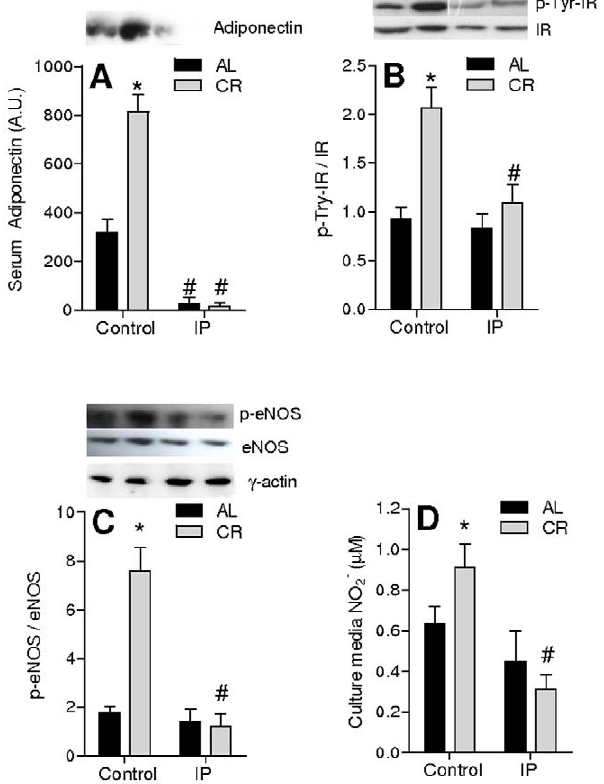
Figure 4. Adiponectin in CR serum promotes insulin receptor and eNOS phosphorylation, resulting in NO N release. ( A ) Adiponectin levels in AL and CR sera before and after immunoprecip- itation (IP). ( B ) Tyr phosphorylation in insulin receptors immunoprecip- itated from homogenates of VSMC cultured for 24 h in the presence of CR or AL serum, with (IP) or without (Control) prior adiponectin immunoprecipitation. ( C ) eNOS Ser1177 phosphorylation in homogenates from VSMC cultured for 24 h in the presence of CR or AL serum, with (IP) or without (Control) prior adiponectin immunoprecipitation. ( D ) NO 2 2 levels in the media from VSMC cultured for 24 h in the presence of CR or AL serum, with (IP) or without (Control) prior adiponectin immunoprecipitation. *p , 0.05 versus AL; # p , 0.05 versus control. Representative blots, shown above quantifications, were cut to remove other bands, without any further image manipulation.